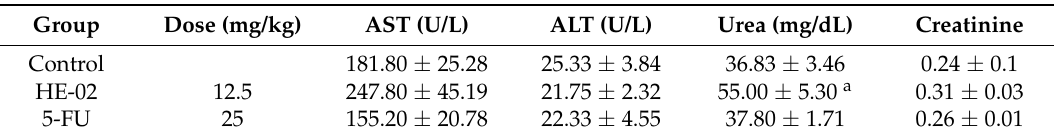
Table 3. Effects of HE-02 and 5-FU on biochemical parameters of peripheral blood of mice ( n = 6) subjected to different treatments (9 days).